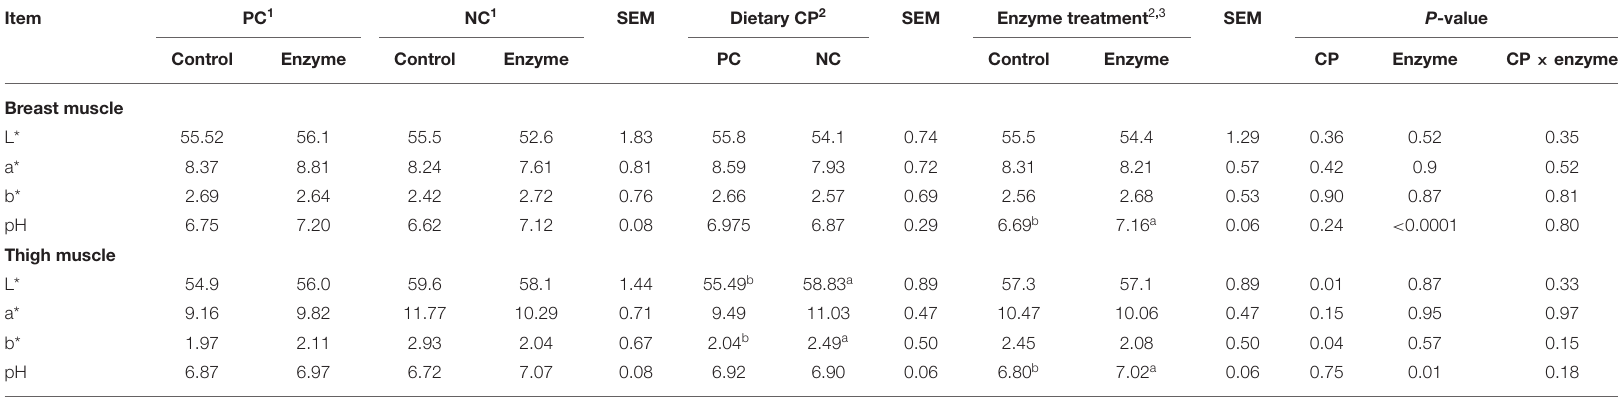
TABLE 4 | Effects of NSP enzymes and protease on meat quality of yellow-feathered broilers fed with diets with different CP levels on day 56. Item PC 1